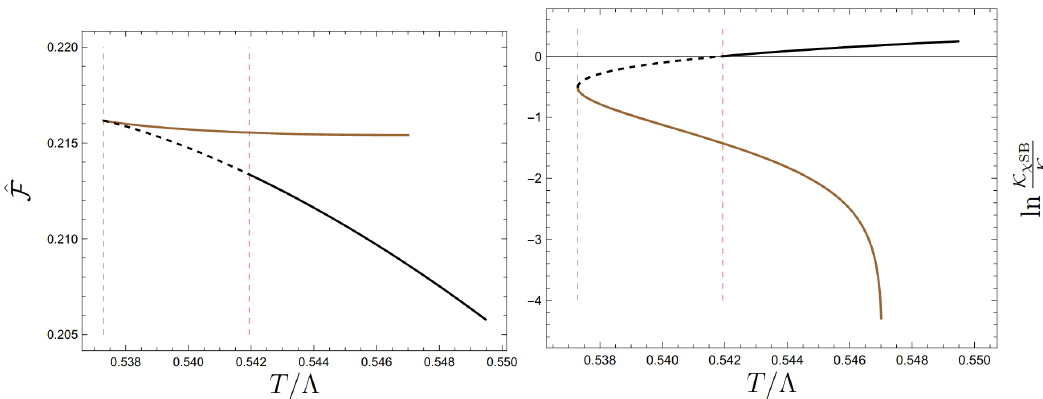
ˆ Figure 2 . The left panel: the reduced free energy density F (2.7) of the deconfined chirally symmetric phase with the positive specific heat (the black curves), and the deconfined chirally symmetric phase with the negative specific heat (the brown curve) of the cascading gauge theory plasma. The vertical dashed brown lines indicate T (2.11). The negative specific heat phase is u exotic: it extends for T > T with ever increasing thermal expectation values of certain gauge u invariant operators. The right panel: the Kretschmann scalar K for the corresponding phases computed for the dual black branes at the horizon. As in figure 1, we normalize the Kretschmann scalar to its value at T χ SB